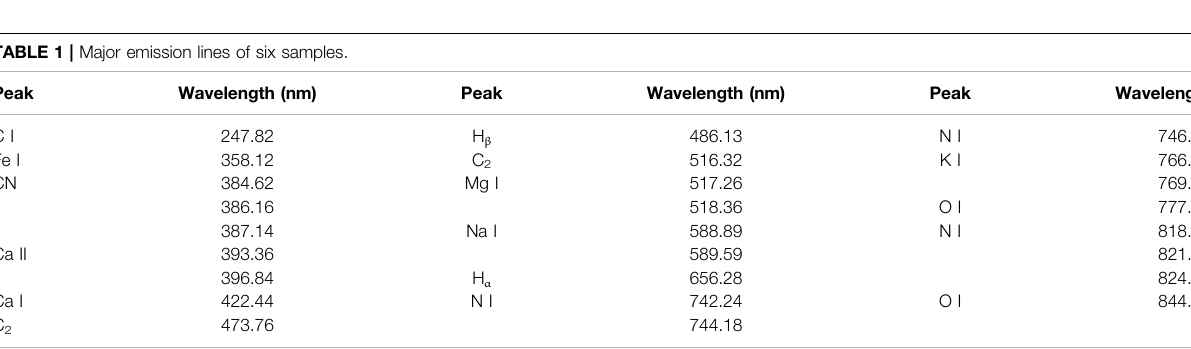
TABLE 1 | Major emission lines of six samples.